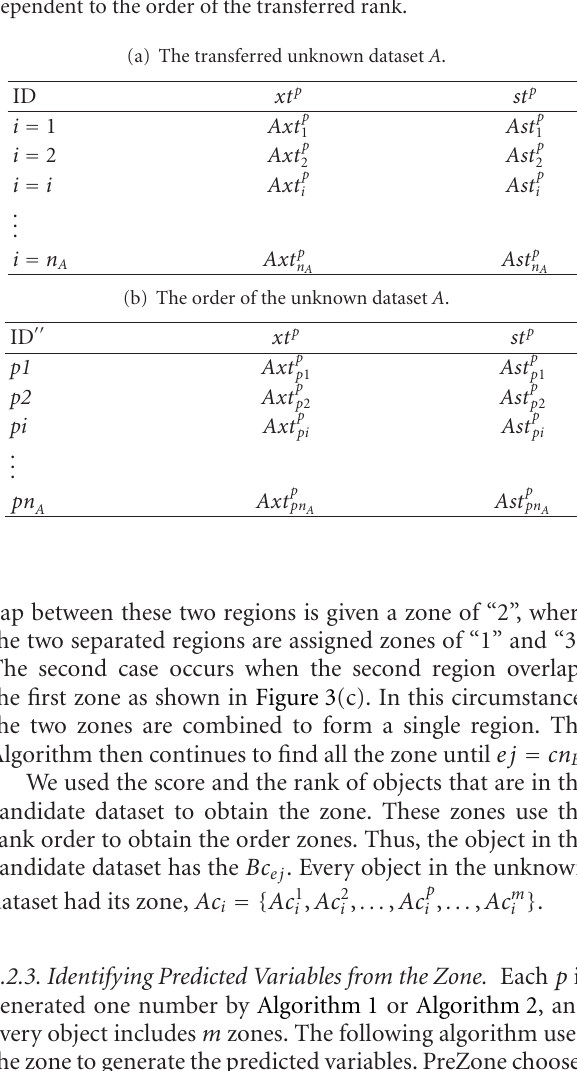
Table 3: Order of the unknown dataset A . 3(a) shows that the rank in the unknown dataset is transformed into a known dataset by the rank transformation, (1). The transferred ranks are { Ast 1 i , Ast 2 i , ... , Ast m i } . The score in the unknown dataset is transformed into a known dataset by the score transformation, Equation (1). The transferred scores are { Axt 1 i , Axt 2 i , ... , Axt m i } . 3(b) is order of the unknown dataset. ID (cid:3)(cid:3) is an identity object but its order